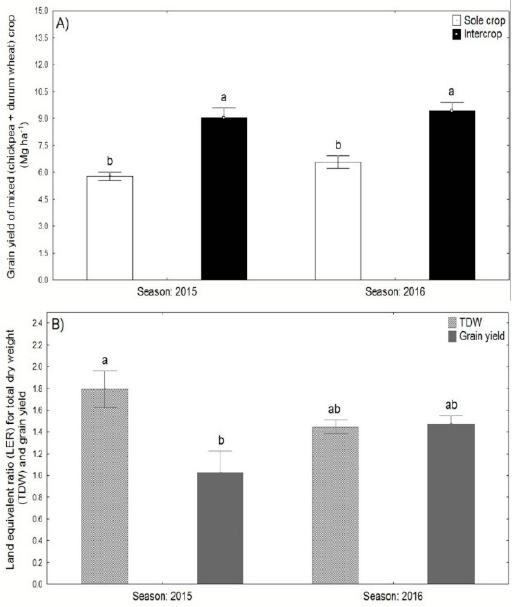
Figure 3. Grain yield of mixed crop (chickpea + durum wheat) per land area ( A ) and land equivalent ratio (LER) for total dry weight (TDW) and grain yield in 2015 and 2016 ( B ). Data are means and SE of four replicates. Bars with the different letters compare cropping systems and years within a crop and are significantly different at p < 0.05.